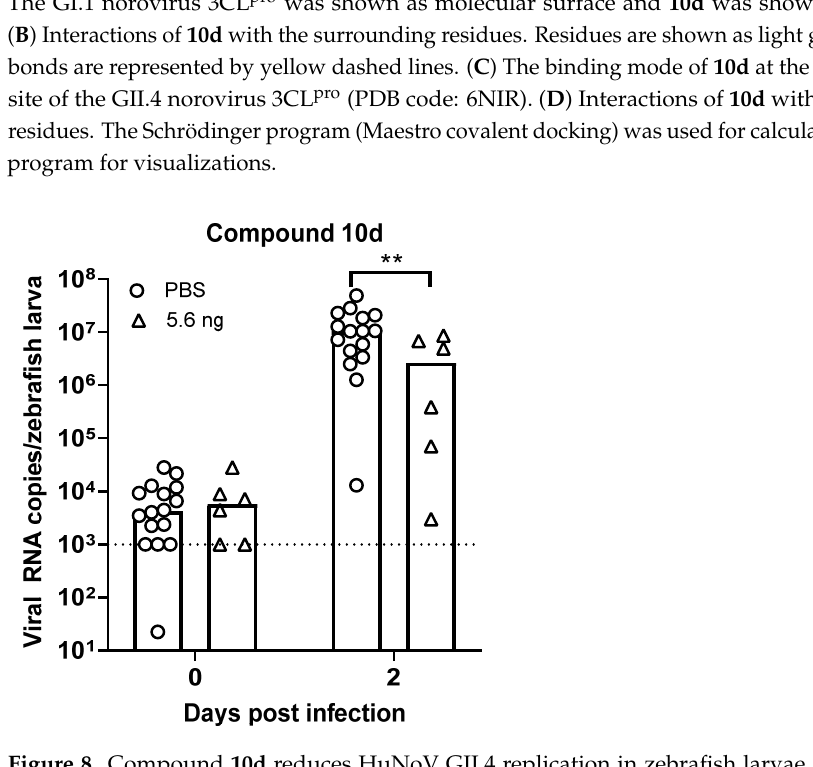
Figure 8. Compound 10d reduces HuNoV GII.4 replication in zebrafish larvae. Single treatment of zebrafish infected with HuNoV GII.P4-GII.4 with compound 10d ( n = 6–11). The dotted line represents the limit of detection (LOD), mean values ± SEM, Mann–Whitney test, ** p < 0.01.